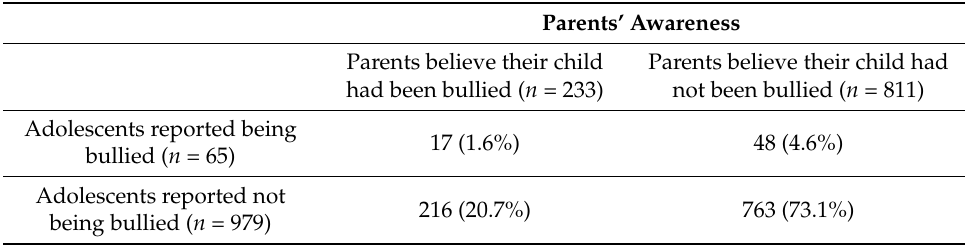
Table 2. Agreement between the student reports of being bullied and the parents’ awareness of their child being bullied.